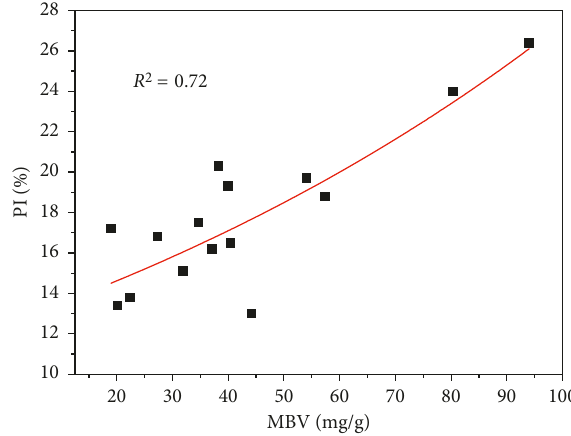
Figure 2: Correlation between MBV and PI.